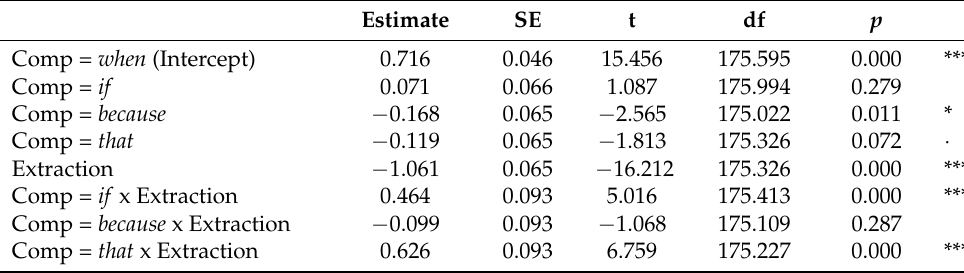
Table 8. Summary of the mixed effects model of Complementizer and Extraction ( z -transformed ratings, target sentences (adjunct islands)), using when as intercept. *** p < 0.001, * p < 0.05, marginal: · p <